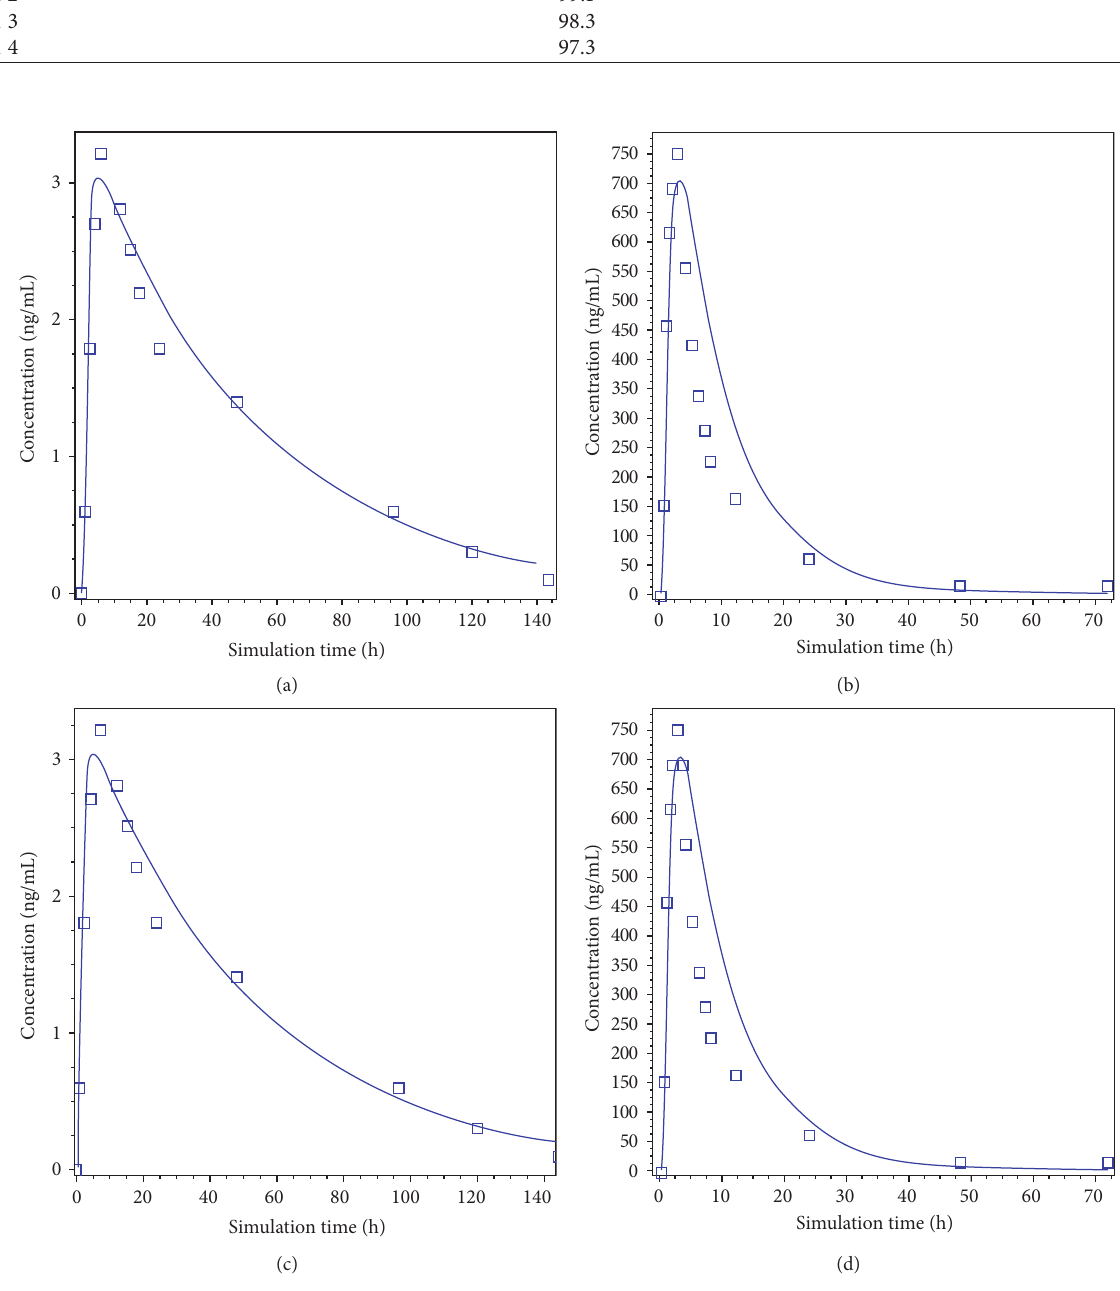
Table 4: The mean percentage of the active ingredient in AML/VAL suspension throughout 4-week period at room temperature. Weak AML VAL Initial 102.1 106.2 101.8